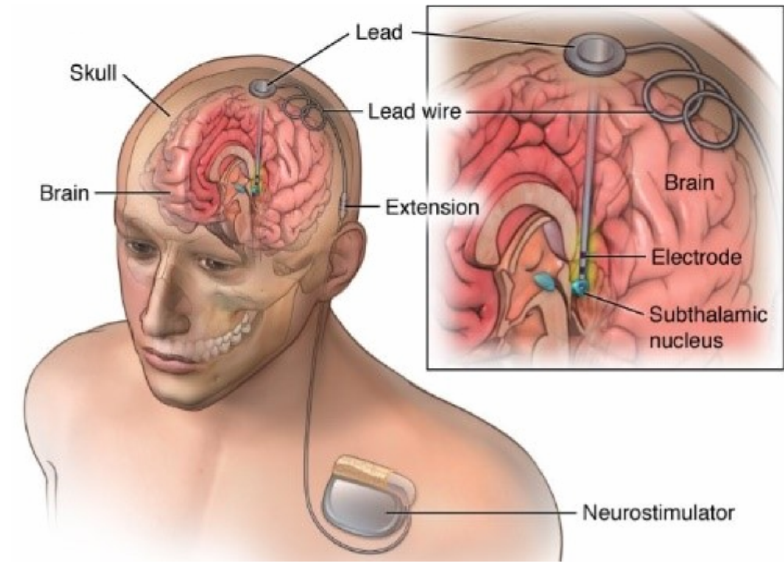
Figure 1. Concept of deep-brain stimulat i on